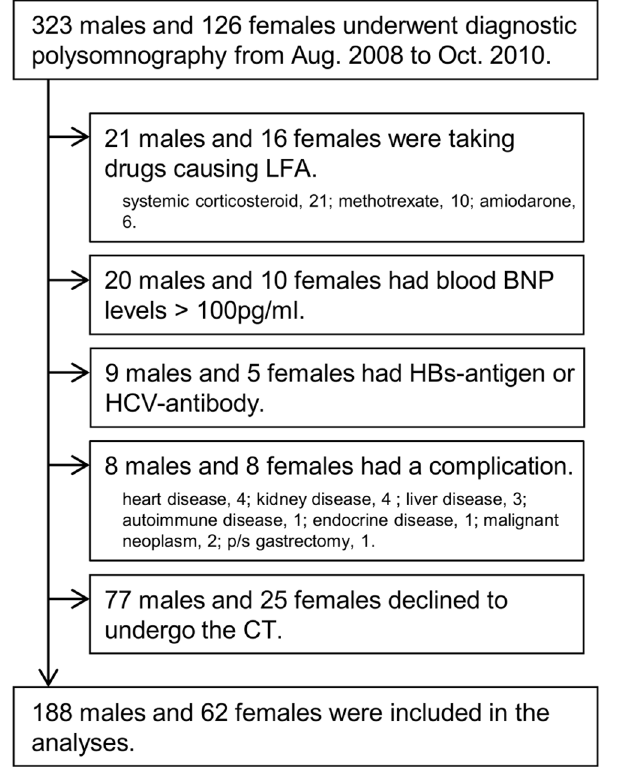
Fig 1. Flow chart of enrollment of study participants.